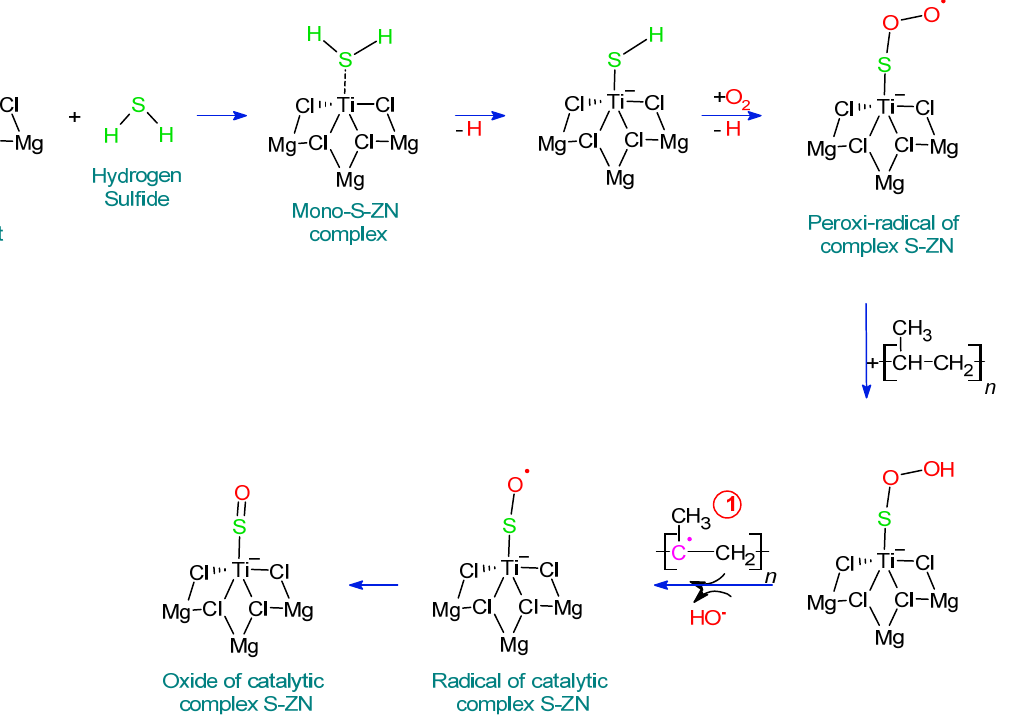
Figure 2. Reaction mechanism of residual H 2 S with TiCl 4 /MgCl 2 .